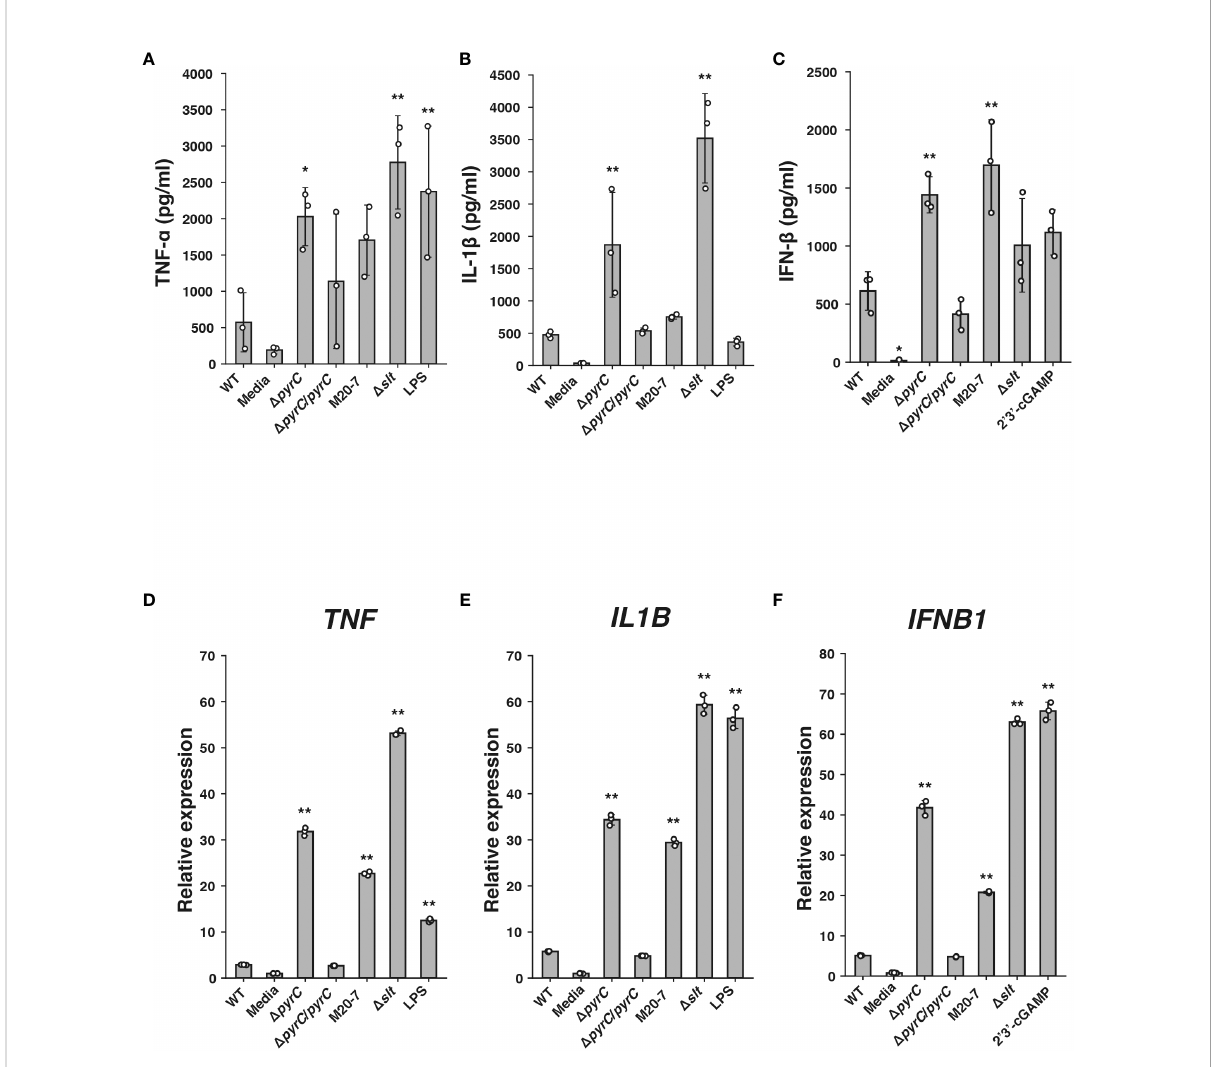
FIGURE 2 Cytokine induction by the F novicida pyrC deletion mutant. U937 cells were stimulated with 100 ng/ml of E coli LPS-containing medium or 10 ng/ml 2 ′ 3 ′ -cGAMP- or same volume BHIc-containing medium or infected with F novicida strains (MOI = 1). Cell supernatants were collected and concentrations of TNF- a at 5 h post infection (p.i.) (A) , IL-1 b at 12 h p.i. (B) , and IFN- b at 24 h p.i. (C) were measured by ELISA. Total RNA was collected, and mRNA expression of TNF at 5 h p.i. (D) , IL1B at 5 h p.i. (E) , and IFNB1 at 12 h p.i. (F) was measured by qPCR; relative expression normalized to that in the same volume BHIc-containing medium treatment control are shown. Data shows averages and standard deviations from three independent experiments. Differences compared with the wild-type strain were determined by Dunnett ’ s multiple comparison and are indicated by asterisks ** P < 0.01, * P <